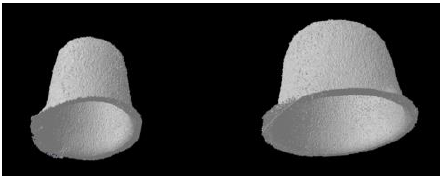
Figure 3. 3D reconstructed image of internal gap between the surface of model and the inner surface of prosthesis. The volume of this image was defined as Internal gap volume (IGV).